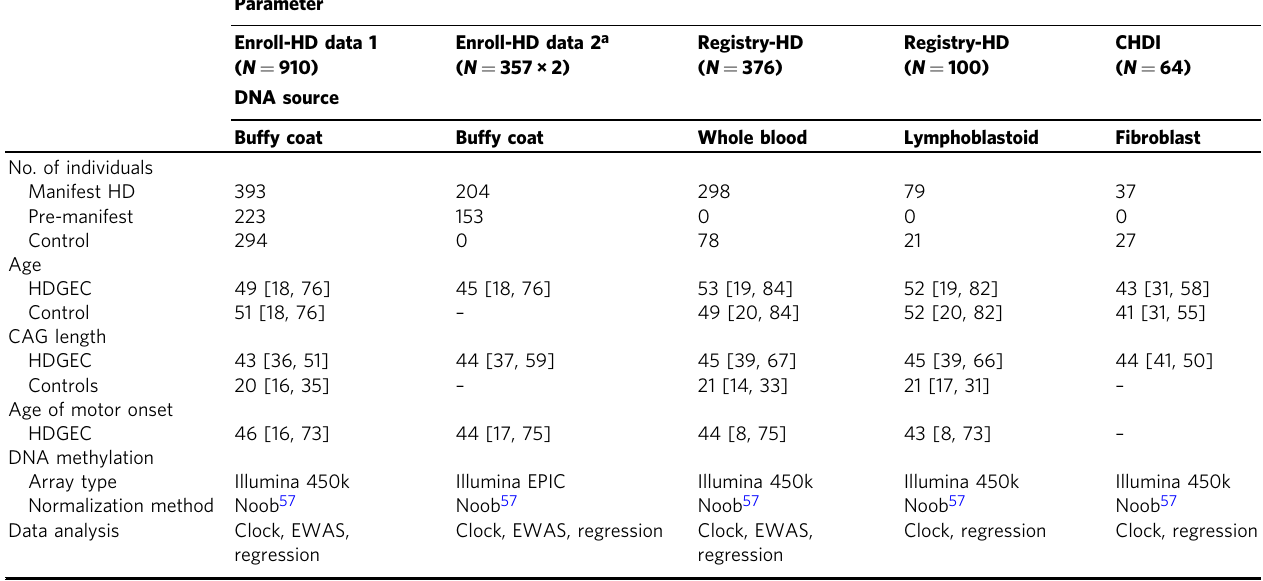
Table 1 A total of 2164 methylation samples across blood, lymphoblastoid, and fi broblast tissues were used for human cross- sectional